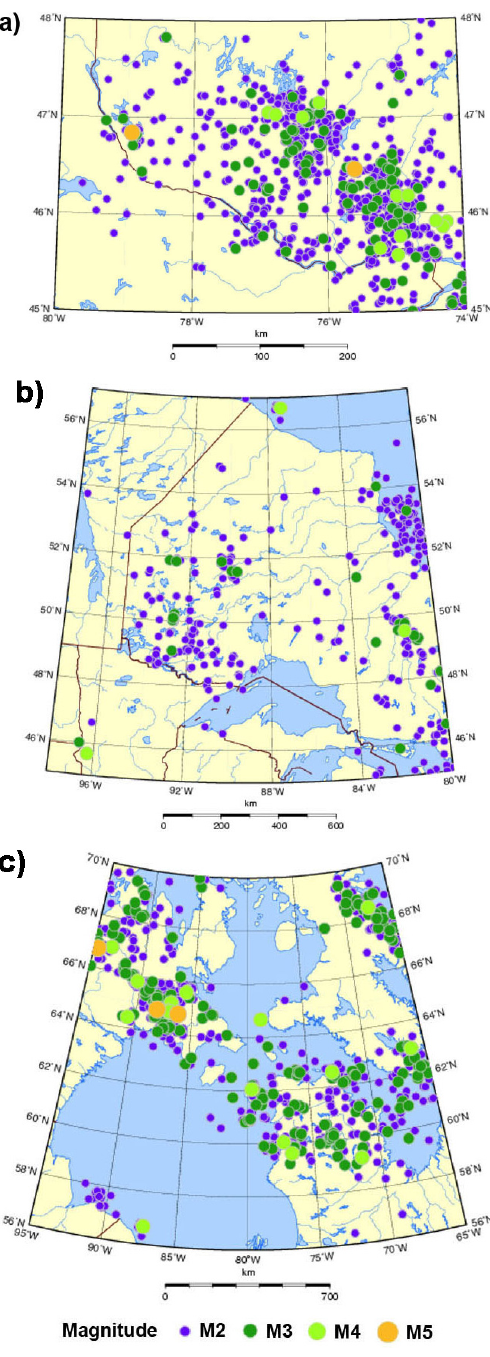
Fig. 2. (a) Seismicity map of Ottawa-Bonnechere (Region 1: latitude/longitude values: 45 ◦ –48 ◦ /74 ◦ –80 ◦ ); (b) seismicity map of northern Ontario (Region 2: latitude/longitude values: 51 ◦ – 55 ◦ /77 ◦ –83 ◦ ); (c) seismicity map of northern Nunavut including Boothia uplift – Bell Arch regions and segments of Baffin Island (Region 3: latitude/longitude values: 56 ◦ –70 ◦ /65 ◦ –95 ◦